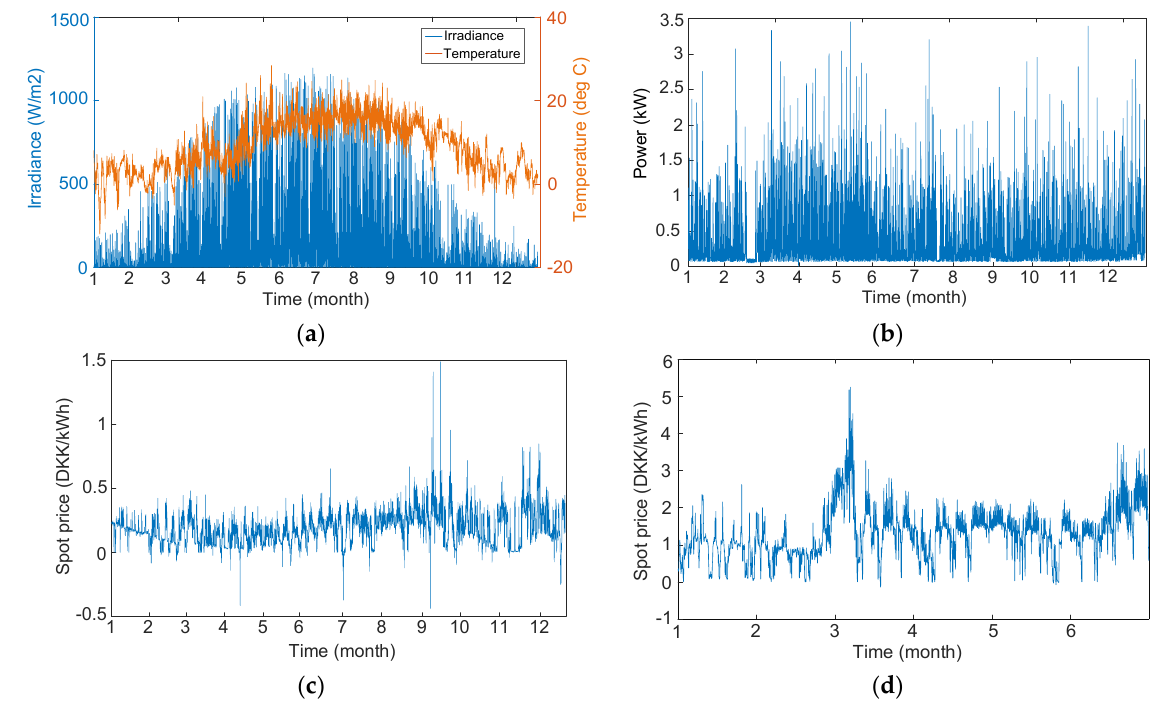
Figure 7. Data profiles: ( a ) PV data; ( b ) load data; ( c ) price data in 2020; ( d ) price data in 2022. The PV–battery system is based on Huawei LUNA2000-(5-30)-S0 [84]. The system structure is shown in Figure 3, and the system parameters are shown in Table 2 below. Table 2. Objectives for minimization of environmental costs.